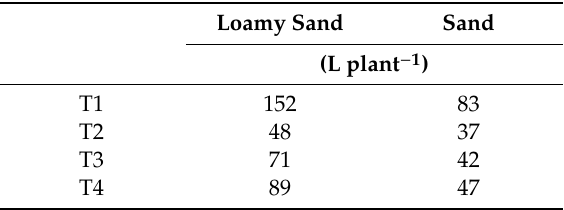
Water supply for irrigation treatments 1–4 (T1–T4) to individual plants during the experimental